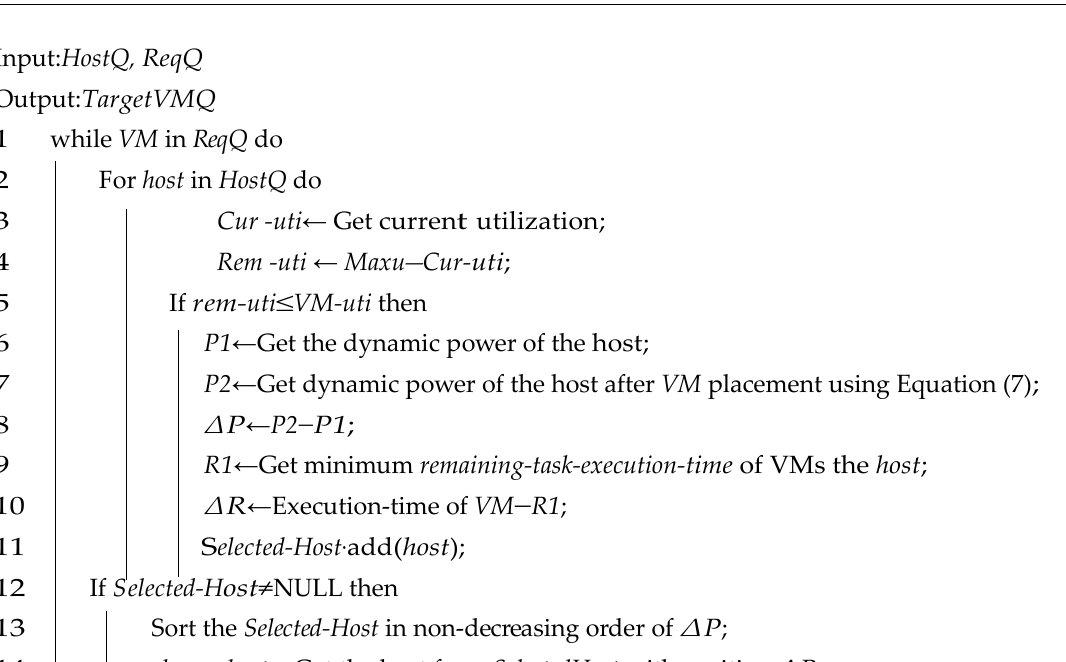
Algorithm 2: Power-Aware algorithm (PA)